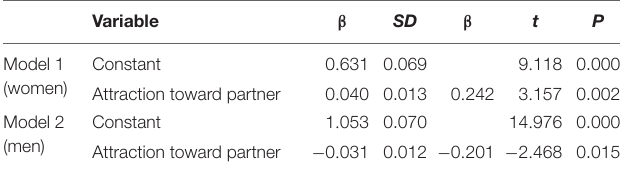
TABLE 4 | Multiple regression models predicting perceptions of date duration.